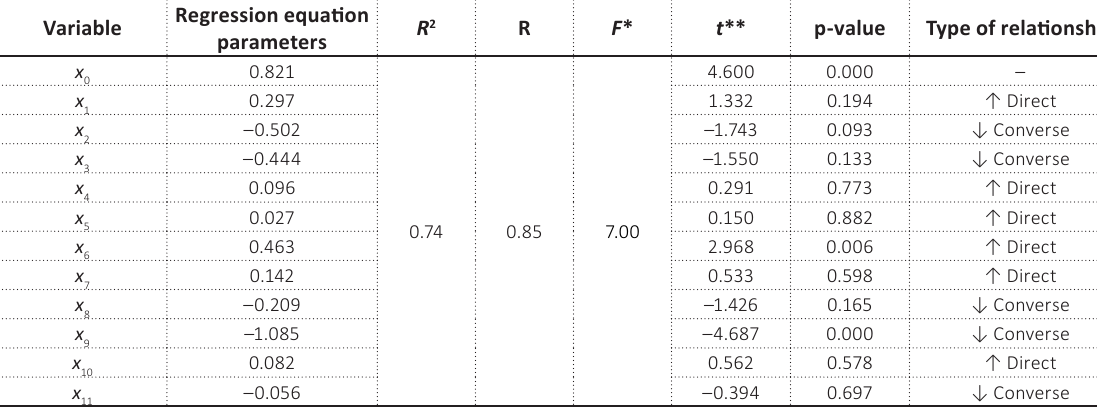
Table 2. Regression analysis results to identify the relationship between government spending and the integrated coefficient of structural changes in GDP by type of activity Variable Regression equation